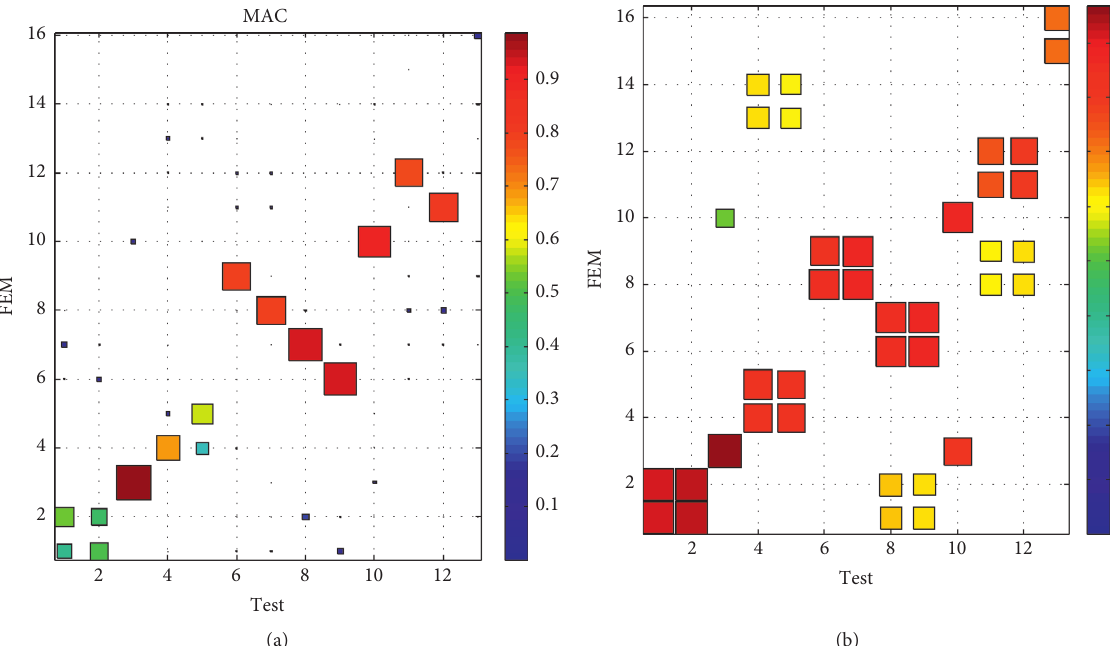
Figure 21: Correlation between the FE model and test. (a) MAC values between the FE model and test. (b) Correlation analysis by RTMs between the FE model and